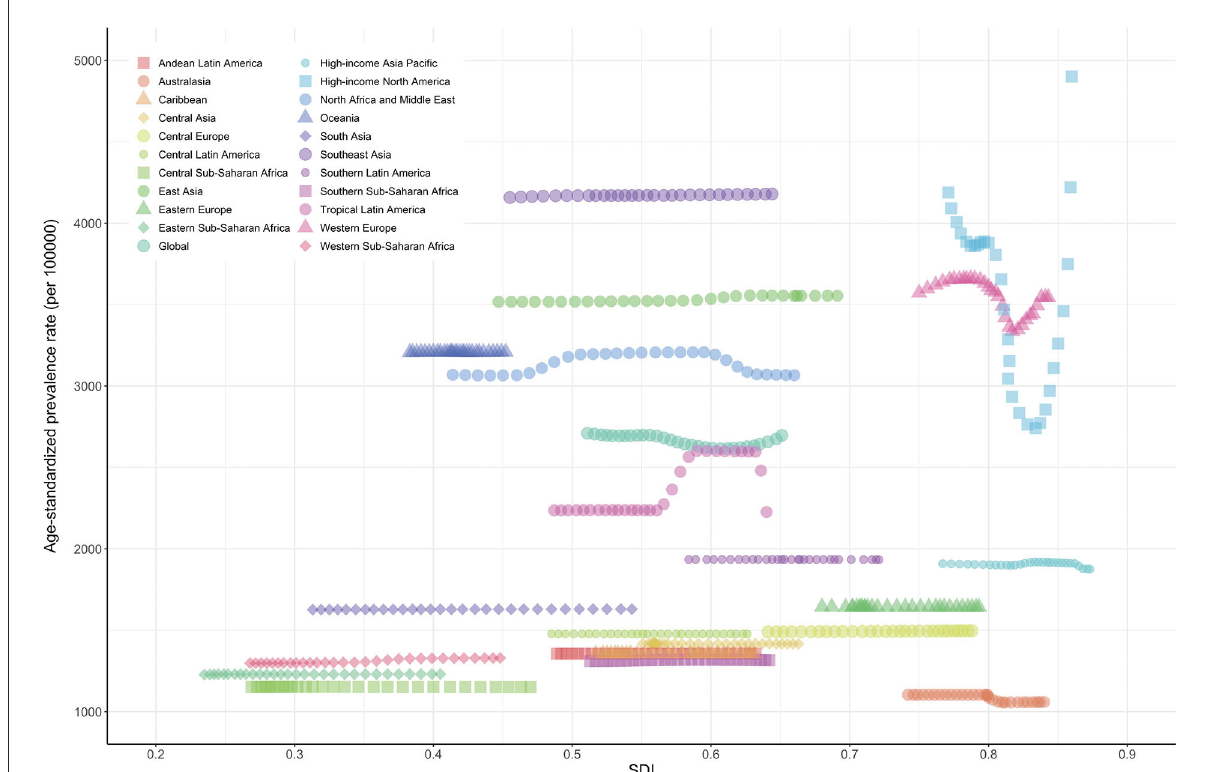
FIGURE3 Age-standardized prevalence rate of neck pain for 21 regions according to SDI in 2019. Thirty points were plotted for each region and observed age-standardized prevalence for that region is shown. Generated from data available at http://ghdx.healthdata.org/gbd-results-tool. SDI, socio-demographic